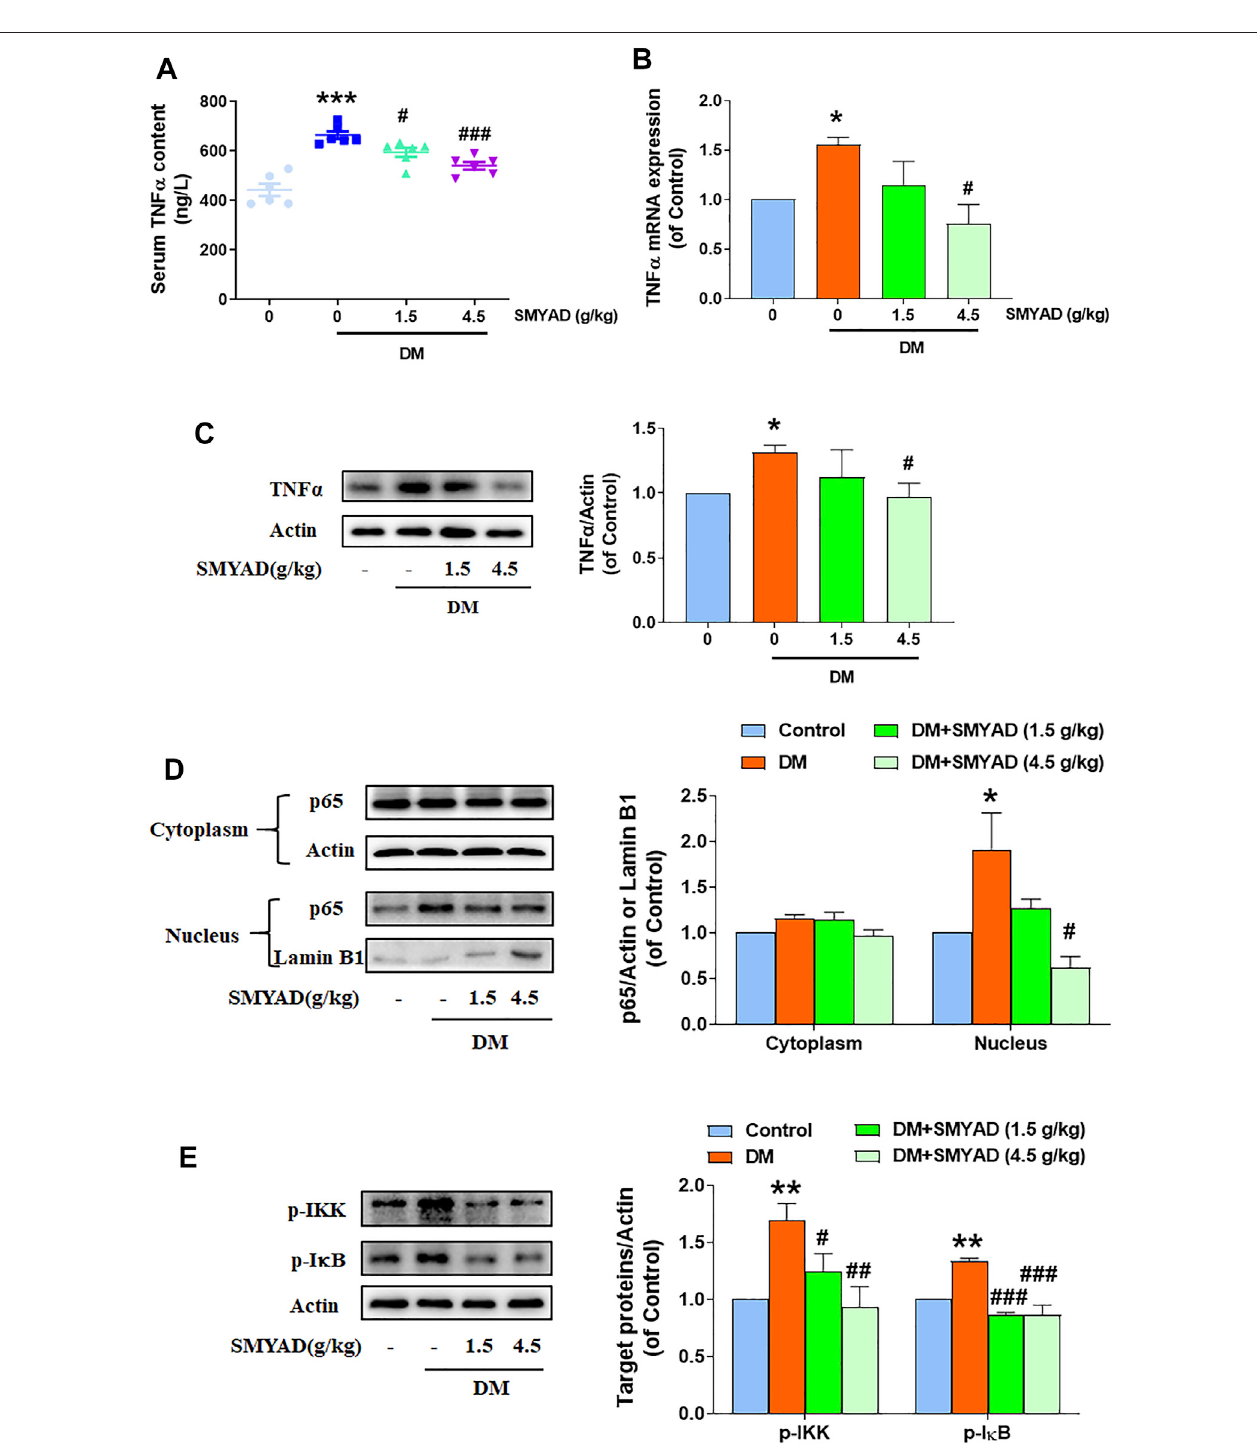
FIGURE5 | SMYAD reduced TNF α expression and blocked NF κ B activation in vivo . (A) Serum TNF α content(n (cid:2) 6). (B) Retinal mRNA expression of TNF α (n (cid:2) 3). (C) SMYAD reduced the enhanced TNF α expression in retinas. The quantitative result is shown below (n (cid:2) 3). (D) SMYAD abrogated the nuclear accumulation of NF κ Bp65inretinas.Thequantitativeresultisshownatright(n (cid:2) 3). (E) SMYADdecreasedtheenhancedphosphorylationofI κ BandIKK.Thequantitativeresultisshown at right (n (cid:2) 3). Data (cid:2) mean ± SEM. * p < 0.05, ** p < 0.01, *** p < 0.001 vs. control; # p < 0.05, ## p < 0.01, ### p < 0.001 vs. DM.